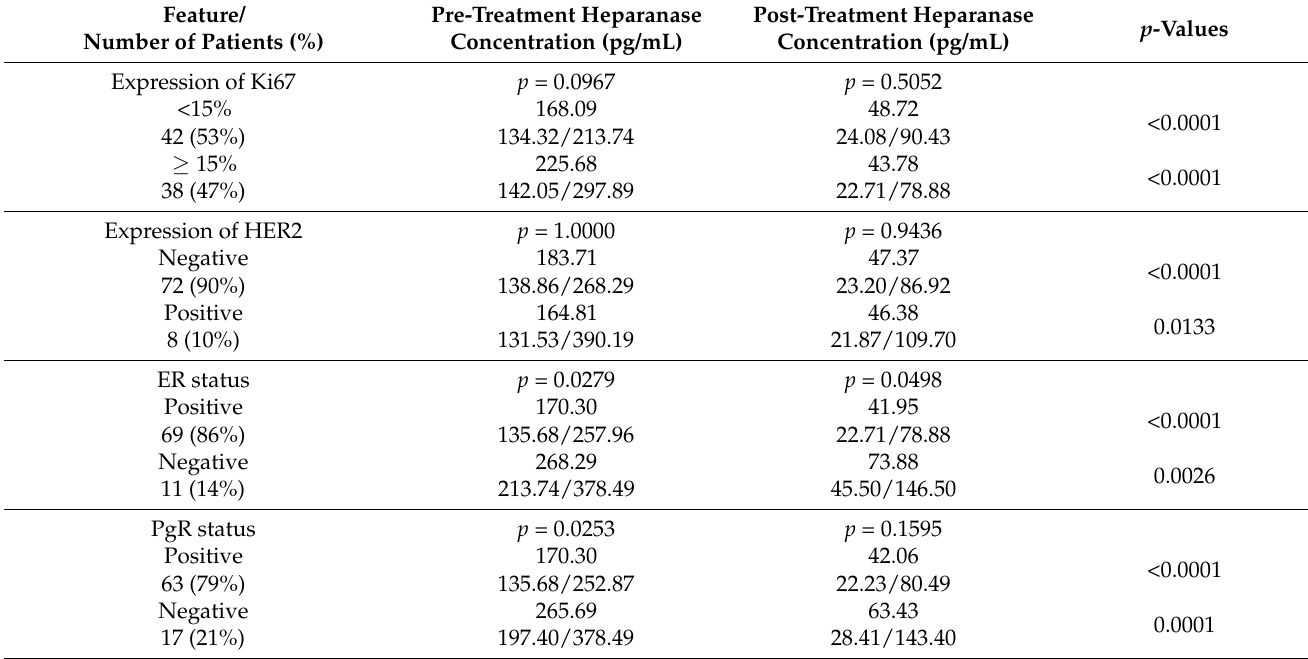
Table 2. The heparanase concentrations according to molecular characteristics in breast cancer subjects.